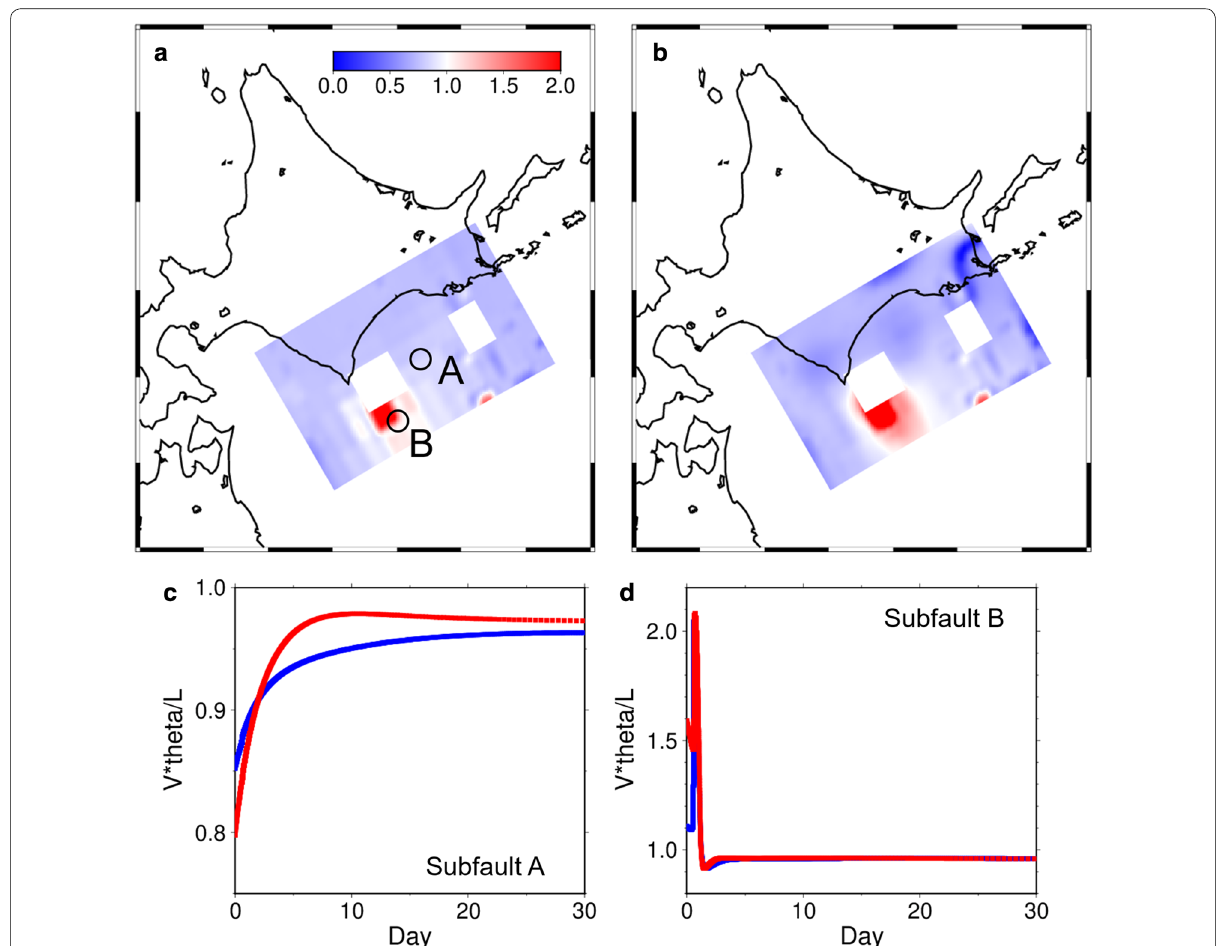
Fig. 13 Spatial distributions of vθ/L and examples of the temporal evolution. The spatial distributions of vθ/L of a only when the frictional parameters are optimized, and b both initial values and frictional parameters are optimized. The temporal evolutions of vθ/L at subfaults c A and d B are indicated by blue and red lines, which correspond to the results of a and b , respectively. The locations of subfaults A and B are indicated in